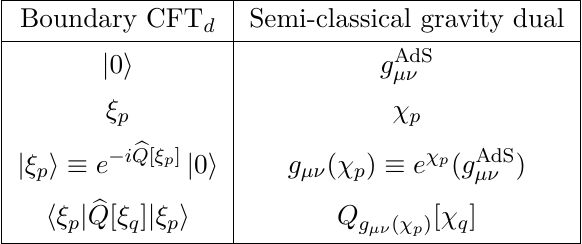
Table 6 . Summary of our holographic proposal relating the boundary states (5.12) to the bulk metrics (5.13), where p = T, R, D . For the boundary charge b Q on the first column we add a hat to remind ourselves it is an operator, written in terms of the stress tensor as in (3.1). The metric g µν ( χ p ) in the second column is given in (5.13), obtained by acting on the pure AdS d +1 metric with the (finite) transformation generated by χ p . Q [ χ q ] corresponds to the Noether charge g µν ( χ p ) associated to the vector χ q computed in the metric g µν ( χ p )